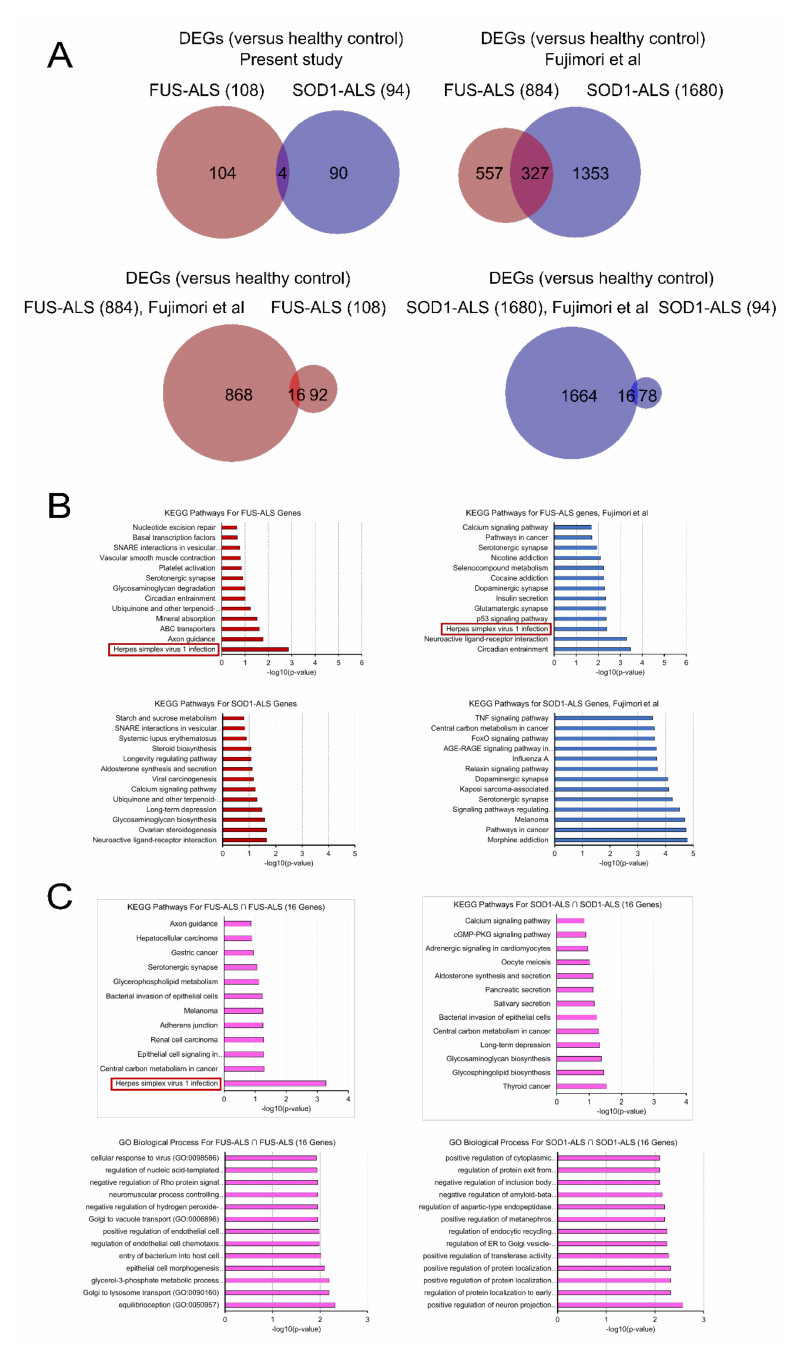
Figure 2. Comparative pathway analysis between the two datasets. ( A ) Venn diagrams showing the number of significantly dysregulated genes in each disease (FUS- and SOD1-ALS) and the observed overlap across comparisons. ( B ) KEGG pathways that are significantly enriched in DEGs specific for each FUS-ALS (upper part) and SOD1-ALS (lower part) disease. ( C ) The significant KEGG pathways (upper part) and Gene Ontology (GO) analysis of biological processes (lower part) enriched by the DEGs shared between FUS-ALS and SOD1-ALS (present study vs. GSE106382) respectively. X-axis represents the statistical significance of the enrichment (-log10( p -value)). Color coding represents disease